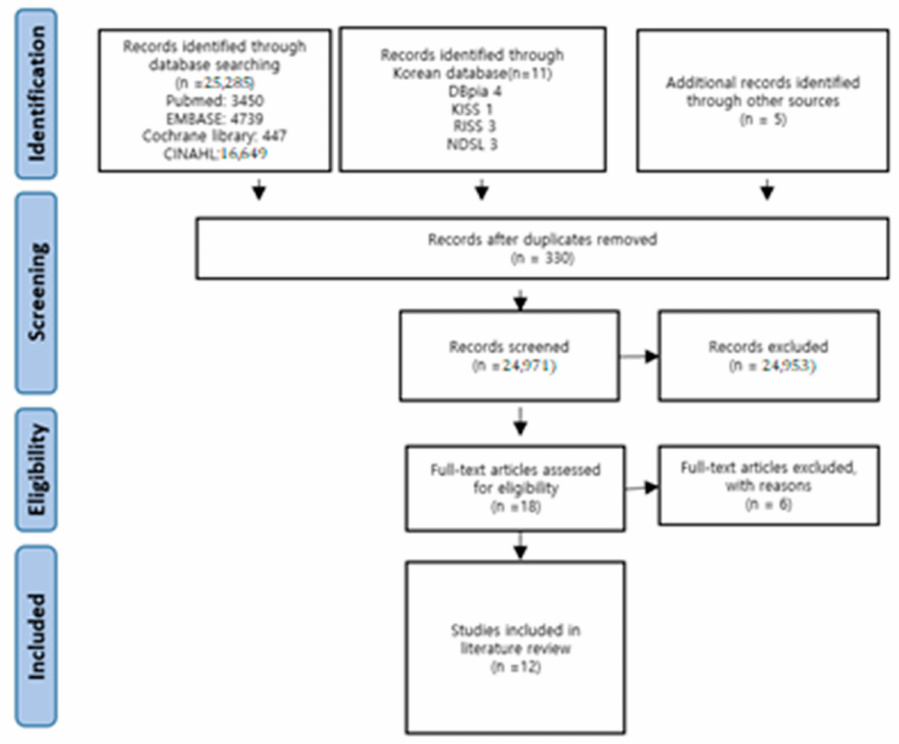
Figure 1. Flow chart of the study selection